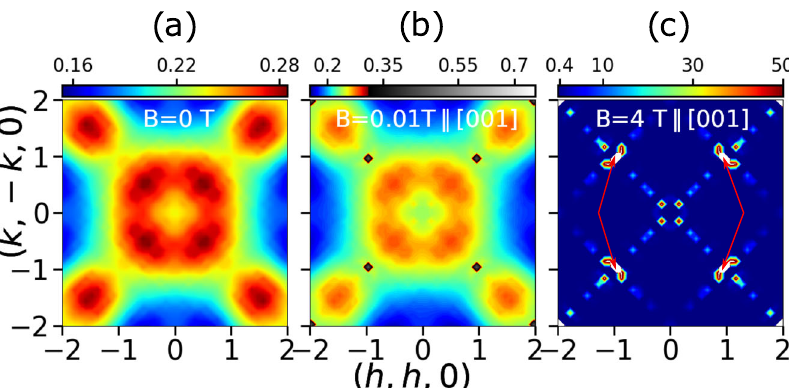
Fig. 4 Predictions for static spin structure factor as expected to be measured in INS. The predicted (energy-integrated) neutron-scattering spin structure factor (in arbitrary units) in a zero fi eld and an applied magnetic fi eld along [001] b B = μ 0 H = 0.01 T and c B = μ 0 H = 4 T, computed using MC calculations for 8192 sites at T = 0.1 K. The Bragg peaks at 4 T, which have intensity value ~3400, appear in the white regions indicated with